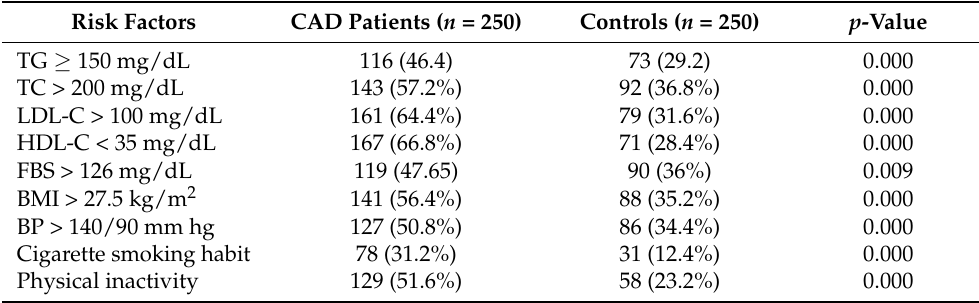
Table 3. Association between cardiovascular disease risk factors and study